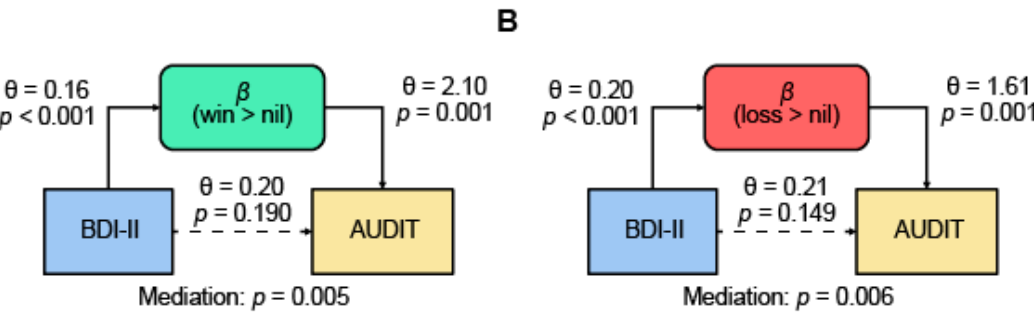
Figure 5. Mediation models: brain activation ( β ) of ( A ) win > nil (in green) and ( B ) loss > nil (in red) of the shared ROIs completely mediated the correlation between BDI-II (in blue) and AUDIT (in yellow) scores. All six models were assessed for each contrast and evaluated at a corrected threshold p = 0.05/6 = 0.0083. The p values associated with mediation are for the path “a × b” (see Section 2). The statistics of all models are summarized in Table 3. Table 3. Mediation models of AUDIT, BDI-II score, and brain activation ( β ) each for win > nil and loss > nil. p